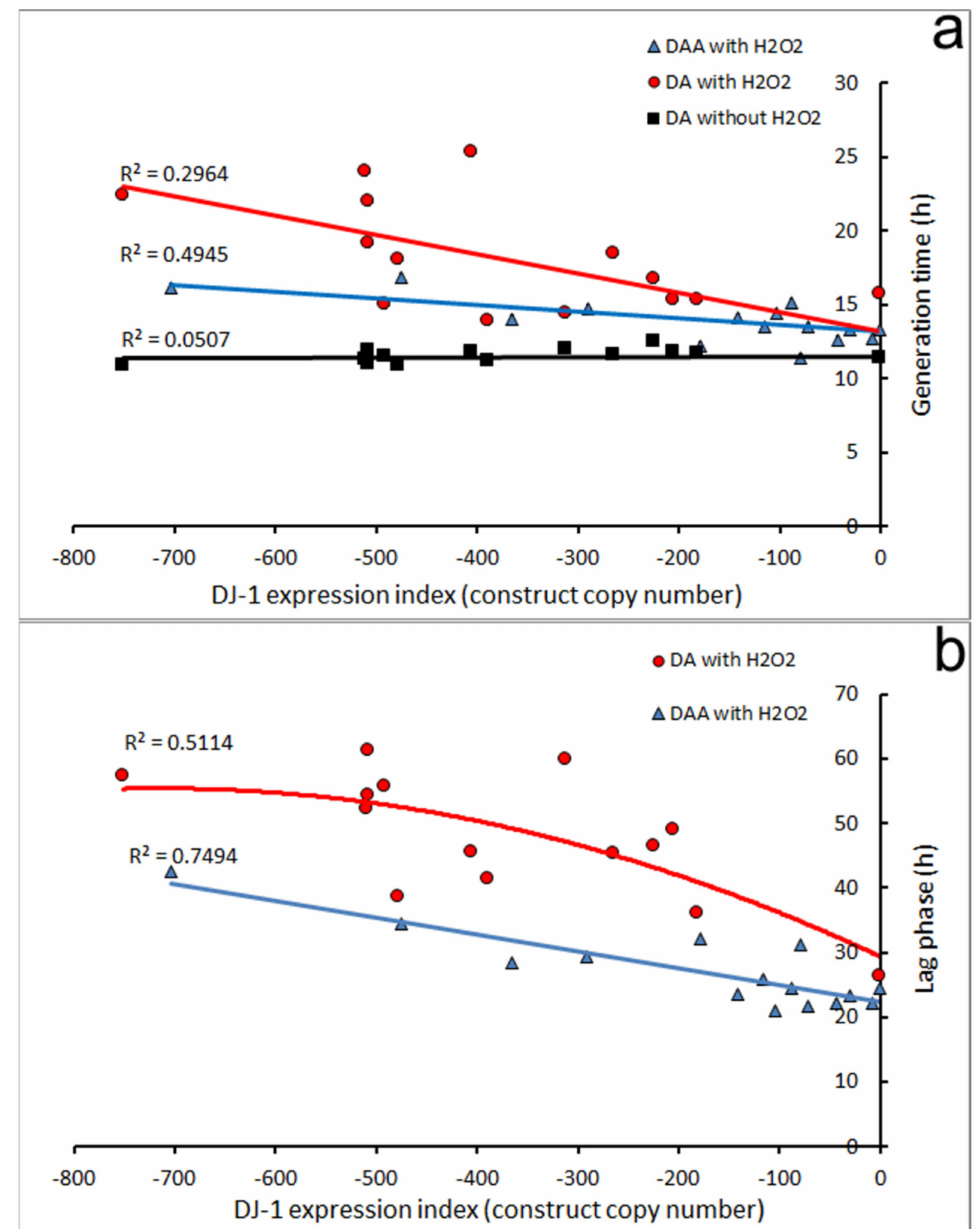
Figure 7. The effect of oxidative stress, DJ-1 and AMPK knockdown on growth in liquid. ( a ): The comparison of generation time between DJ-1 antisense (DA) strains with or without H 2 O 2 and DJ-1/AMPK double antisense) DAA cotransformants with H 2 O 2 . The multiple regression analysis of generation time for DA and DAA strains is shown in Supplementary Table S2. The error bars are not plotted because they made the plot too cluttered. To allow for the easy comparison of results in the presence of H 2 O 2 with those obtained without H 2 O 2 , the previously reported results without H 2 O 2 [16] are included here. In the absence of the DJ-1 knockdown construct (copy number 0), the H 2 O 2 caused the generation time to increase significantly ( p = 0.039) by 1.7 h whether or not the AMPK antisense construct was present (intercepts). In the absence of H 2 O 2 , the knockdown of DJ-1 had no significant effect on the generation time (black line), but in the presence of H 2 O 2, growth was dramatically slowed by DJ-1 knockdown in a copy-number-dependent manner (slope = − 0.013, p = 9 × 10 − 9 , red line). When AMPK expression was also knocked down (blue line), the effect of DJ-1 loss was still significant ( p = 5.9 × 10 − 4 ), but was reduced 3-fold (slope = − 0.0045). This shows that in the presence of H 2 O 2 , the impairment of growth caused by DJ-1 loss is largely mediated by AMPK. ( b ): The comparison of lag time between DJ-1 antisense (DA) and DJ-1/AMPK double antisense (DAA) strains exposed to H 2 O 2 . In the absence of H 2 O 2 , the lag time was 0 in all strains, because they were already growing in exponential phase at the start of the experiment. In the presence of H 2 O 2 , the DJ-1